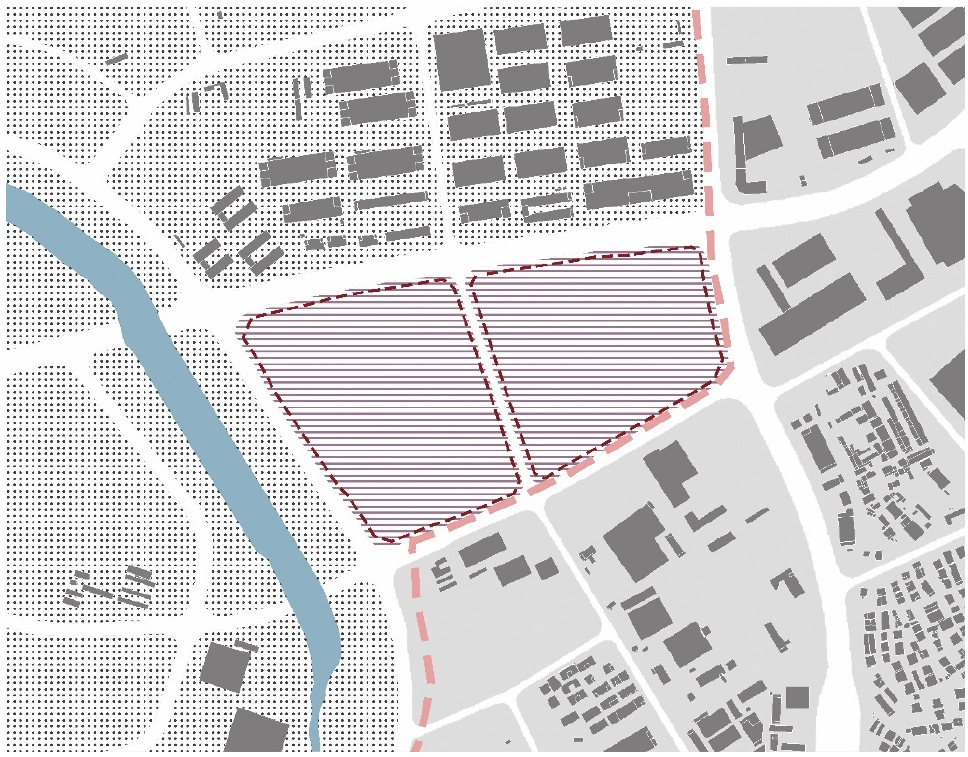
Figure 8. The location of the design plan (Source: author).